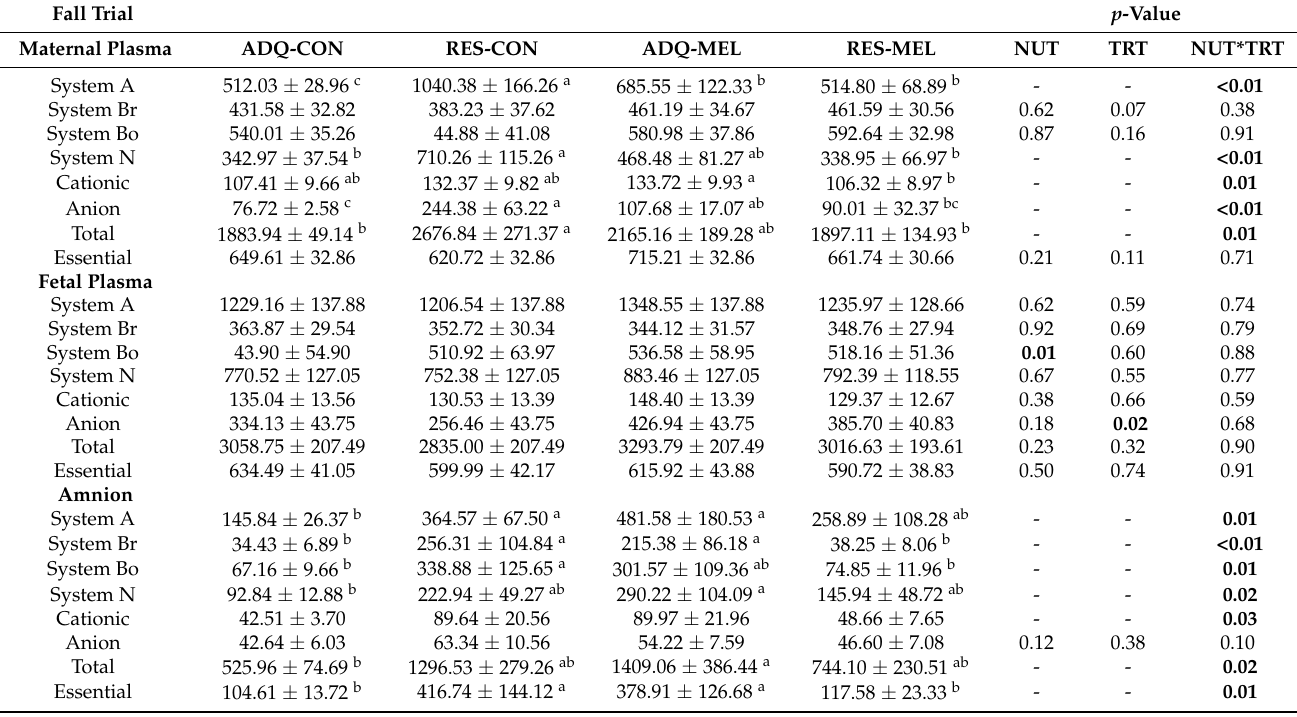
Table 2. Amino acids in maternal and fetal plasma, and amnion by transport system, total amino acids, and essential amino acids in the fall